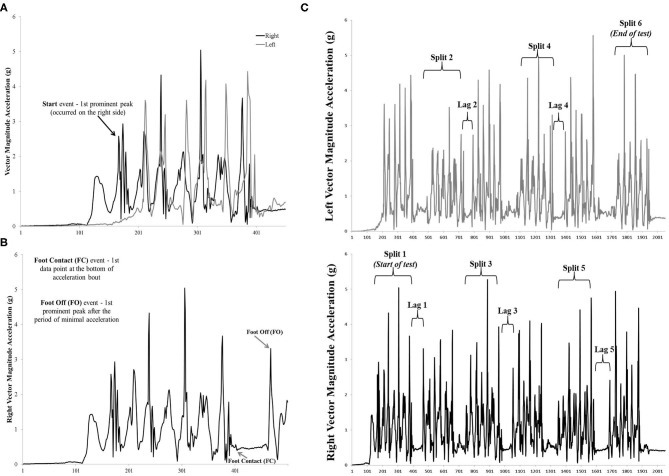
(A–C). Start, Foot Contact (FC) and Foot Off (FO) events identified on the vector magnitude of the acceleration data. (A) Start identified as the first prominent peak of the acceleration data which occurred on the right side in this example. (B) FC event identified as the first data point at the bottom of acceleration bout on the right side acceleration data. FO event identified as the first prominent peak after the period of minimal acceleration on the right side acceleration data. (C) Split time and Lag time periods identified on the vector magnitude of acceleration data from the right and leg left during one attempt of the modified Edgren Side Step Test (mESST). Split time and Lag time duration periods were calculated from the Foot Contact and Foot Off events identified in the acceleration signal of either the right or left leg. For one repetition of the mESST there are six Split Times (subject travels from one end-line to the opposite end-line) and five Lag times (time subject took to transition to movement in the opposite direction).